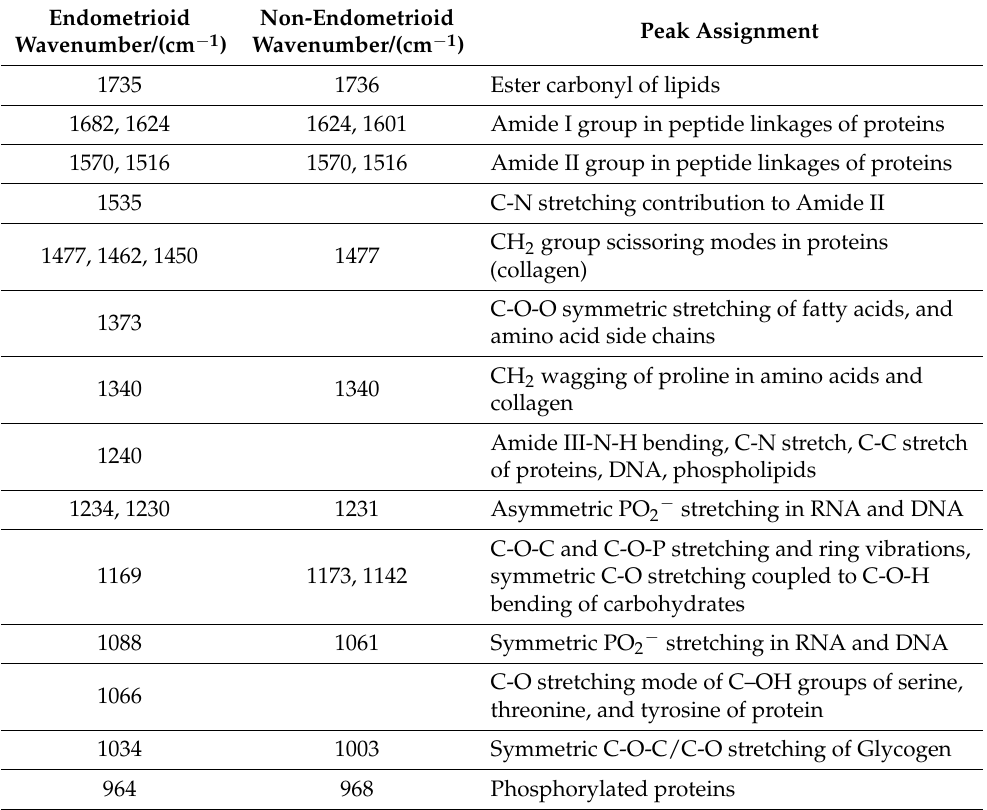
Table 2. Peak assignment of typical FtIR spectra absorption bands observed in endometrioid and non-endometrioid endometrial cancers